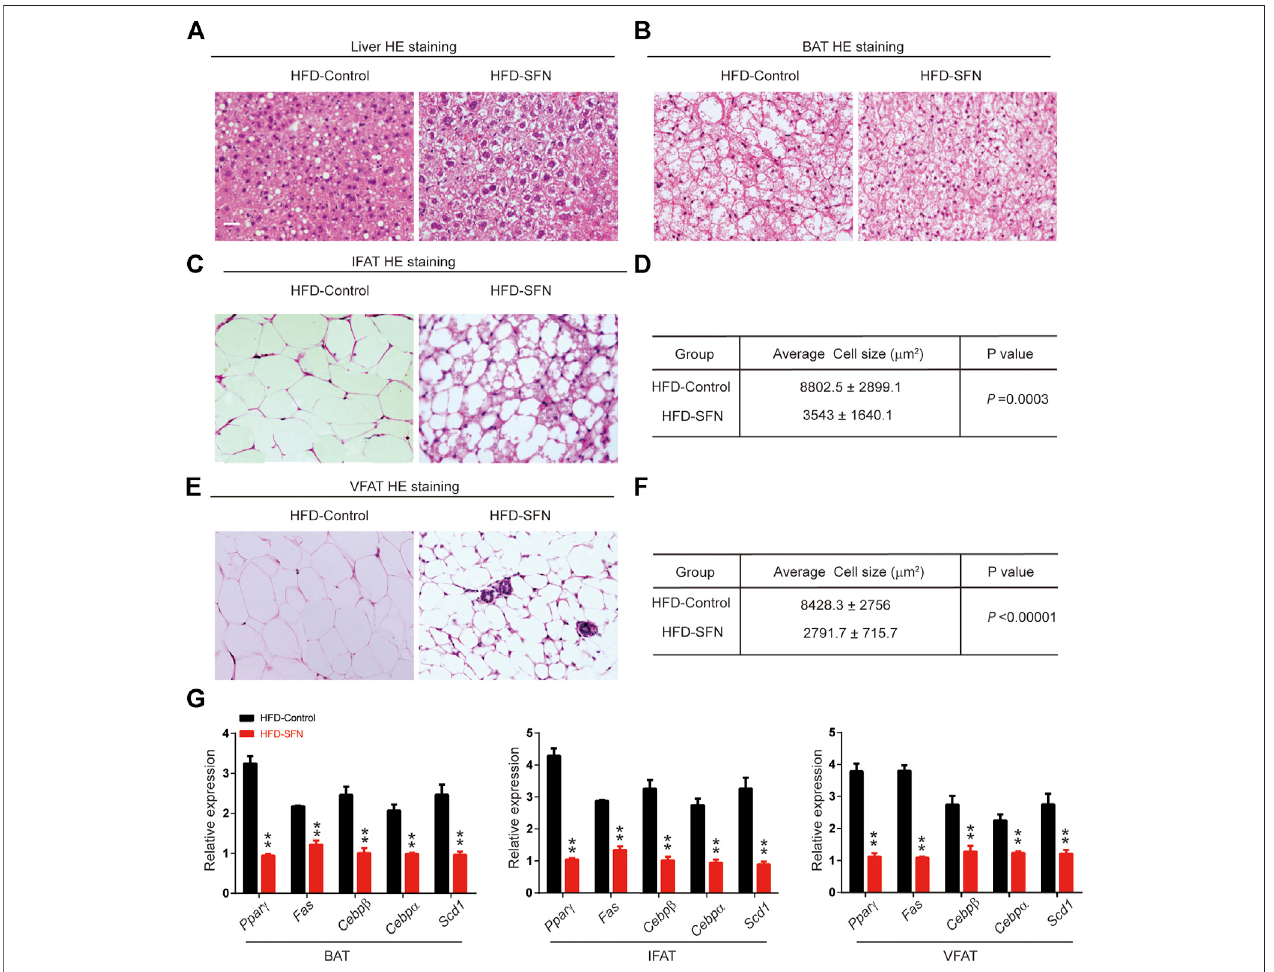
FIGURE6| SFN prevented lipid accumulation inHFD-induced mice. (A,B) HE stainingshowed theeffect ofSFN onthe liverand BAT. (C – F) SFNreduced thelipid dropletsandthesizeofadiposecellfromIWATandVWAT. (G) ChangesintheexpressionadipogenesisgenesindifferentadiposetissuesfromHFD-inducedobesemice without SFN treatment. Scar bar (cid:2) 50 μ m. All the results were expressed in graph with mean ± SD. Statistical signi fi cance was evaluated by Student t test. * and ** represent the signi fi cant difference at p < 0.05, p < 0.01 vs control group.